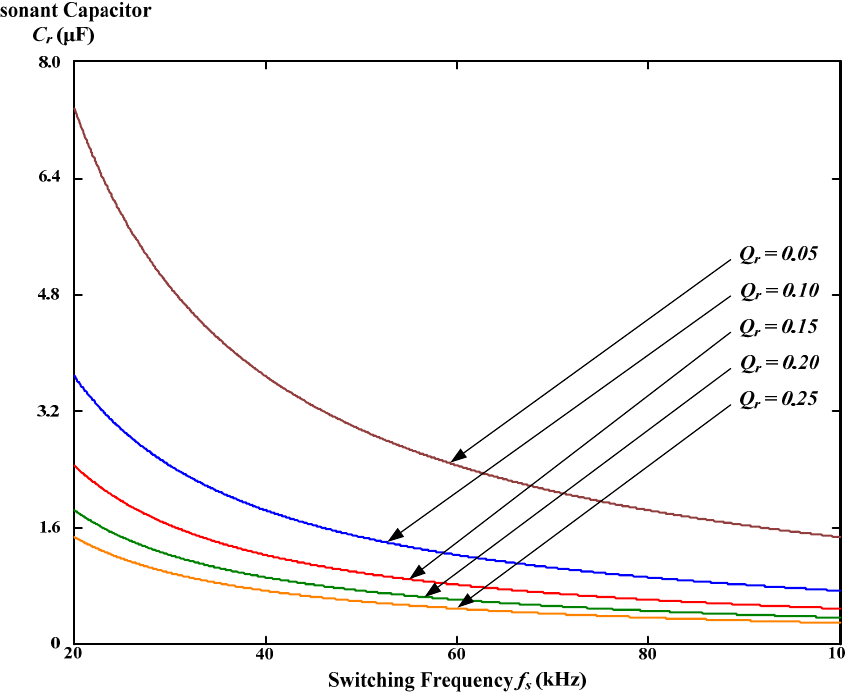
Figure 7. Resonant capacitor C r versus the switching frequency f s under different levels of quality factor Q r .